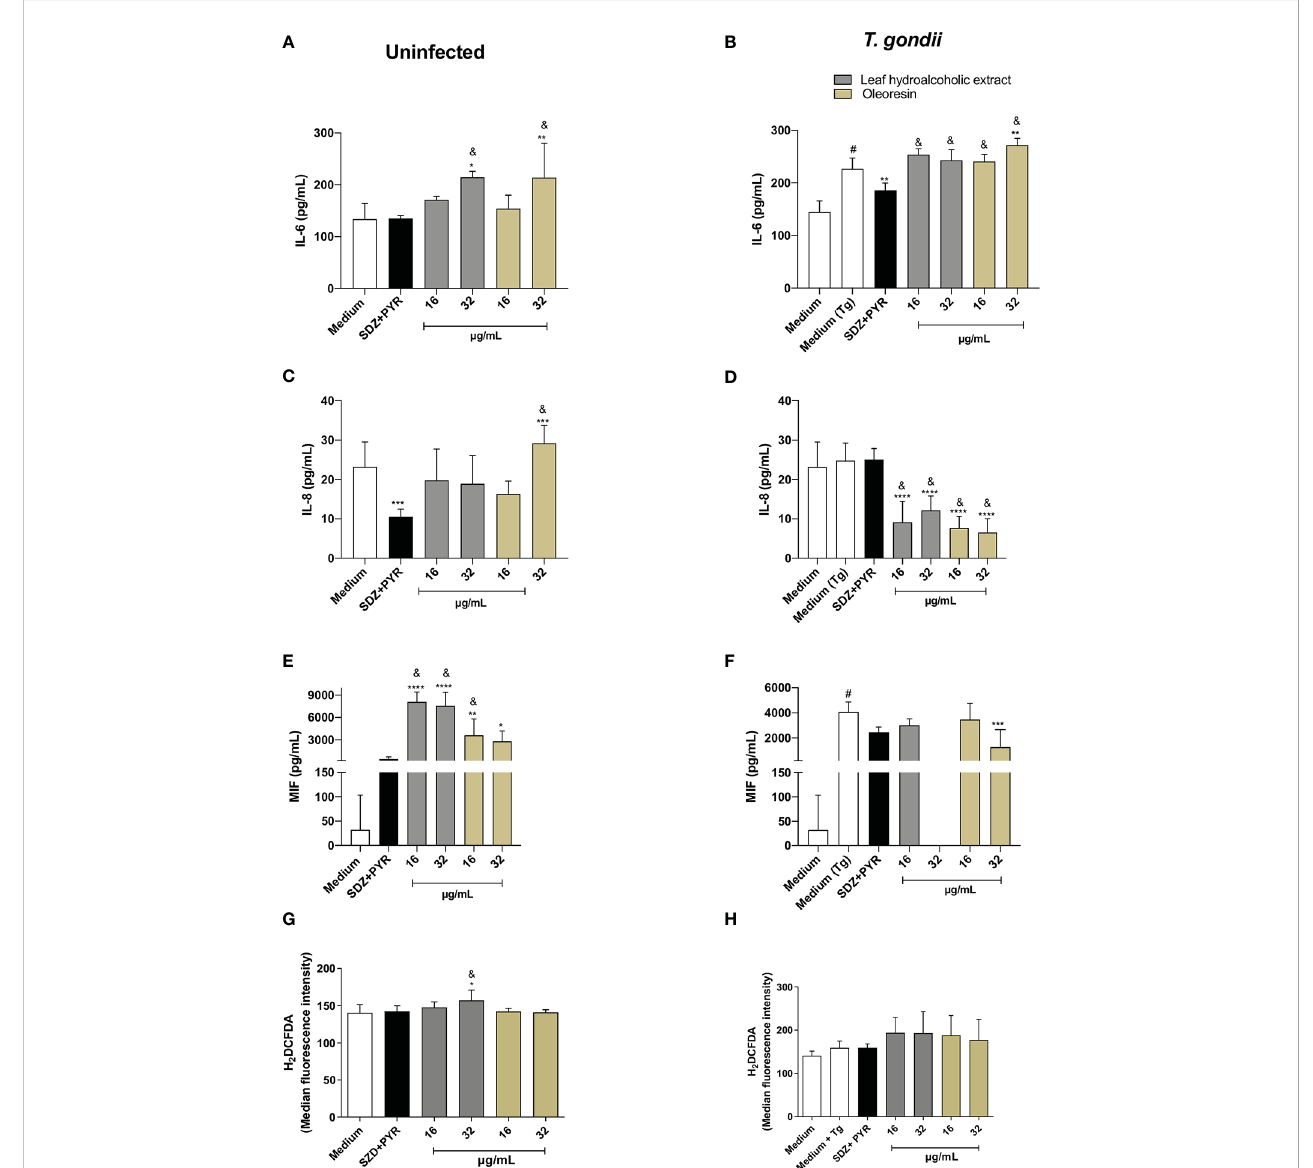
FIGURE 7 Cytokine and ROS production in BeWo cells. BeWo cells were infected and treated or not with the hydroalcoholic extract or oleoresin from C. multijuga for 24 h. Untreated and uninfected cells (medium), untreated and infected cells (medium Tg) and SDZ + PYR were used as controls. Then, supernatants were collected and used to measure IL-6 (A, B) , IL-8 (C, D) and MIF (E, F) . In parallel, BeWo cells were infected, treated or not with the hydroalcoholic extract or oleoresin from C. multijuga for 24 h, incubated with the probe 2 ′ ,7 ′ -dichlorodihydro fl uorescein diacetate (H2DCF-DA), ROS production was measured by a plate reader and data expressed as mean fl uorescence intensity (MFI) (G, H) . The results were expressed as means ± standard deviation of three experiments performed in eight replicates. Signi fi cant differences detected by One-Way ANOVA, Bonferroni ’ s multiple comparisons post-test. * P < 0.01, ** P < 0.001, *** P < 0.0001 or **** P < 0.00001 in relation to medium (for uninfected cells) or to medium Tg (for infected cells). & P < 0.05 in relation to SDZ + PYR (for uninfected or infected cells). # P < 0.05 between medium and medium